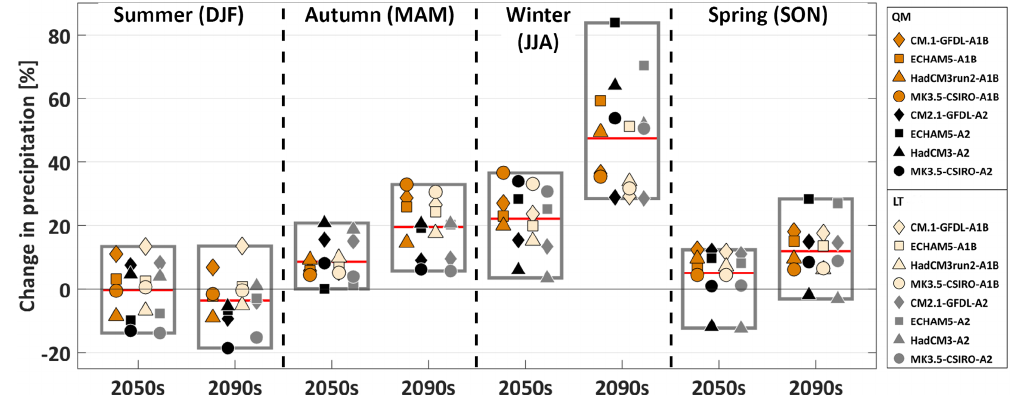
Figure 6. The uncertainty range of the precipitation signal (domain average) is shown for the entire ensemble and the four seasons. For each box the uncertainty range is broken down into the two emission scenarios and the two bias-correction methods. The red line represents the median of all 16